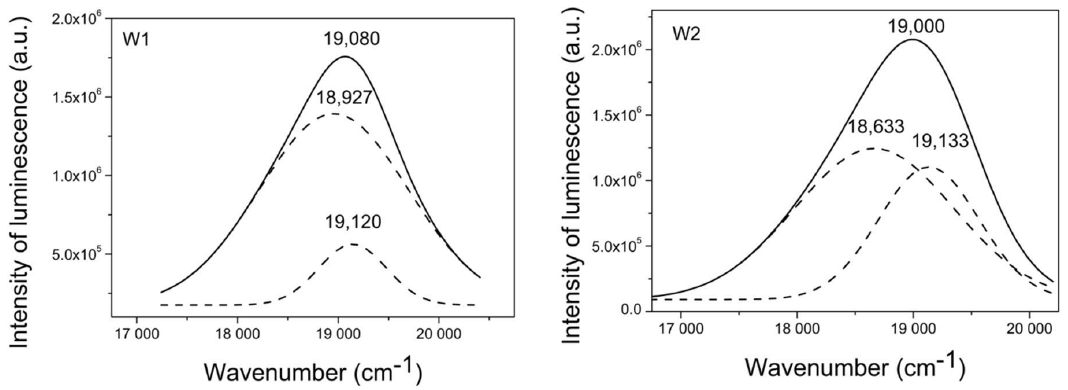
Figure 8. Deconvolution of the Mn 2+ emission band for W1 and W2 samples.